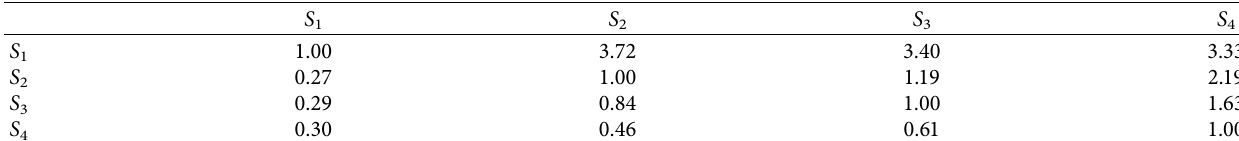
Table 4: Pairwise comparison on social and safety subfactor.